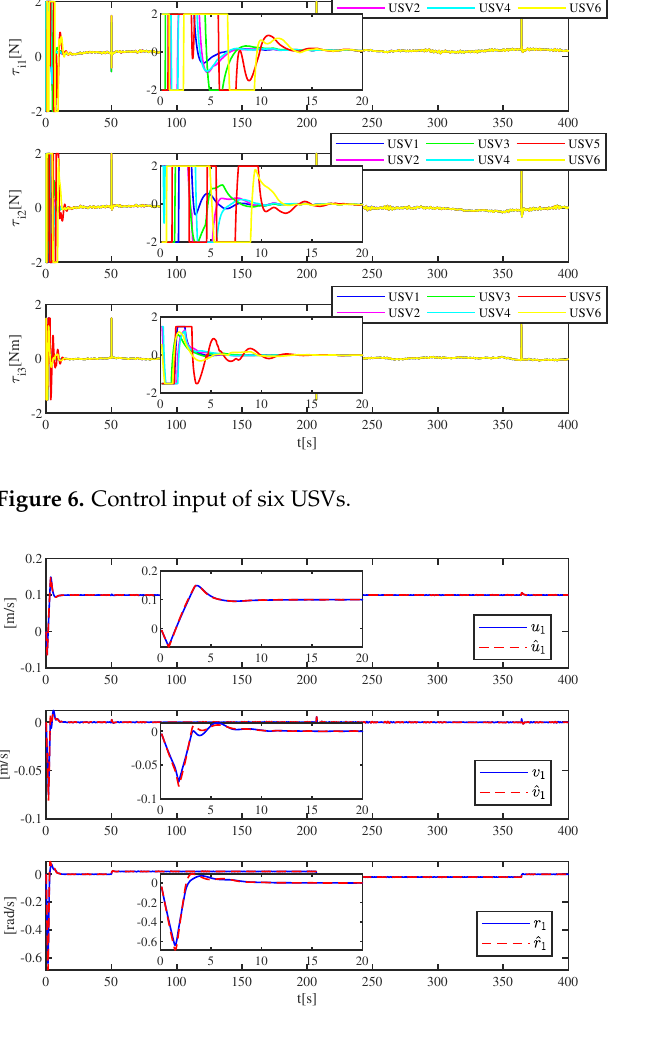
Figure 7. Velocity estimation performance of NASO with solid lines for the real states and dashed lines for their estimation.